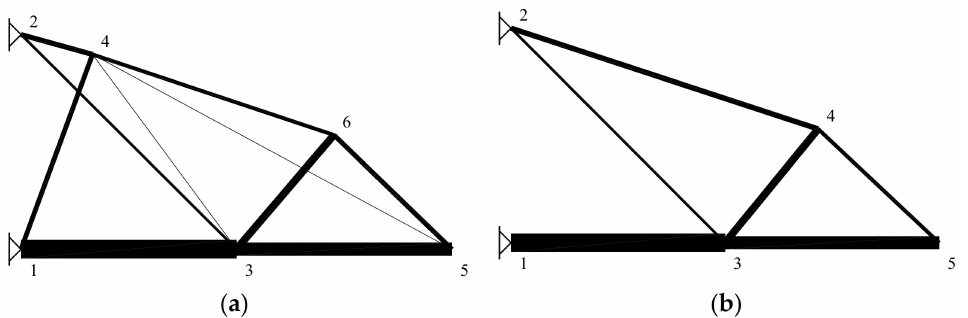
Figure 12. Optimal solutions, example TC10d (topology and shape optimization, with buckling constraints). ( a ) Initial topology; ( b ) optimal topology.